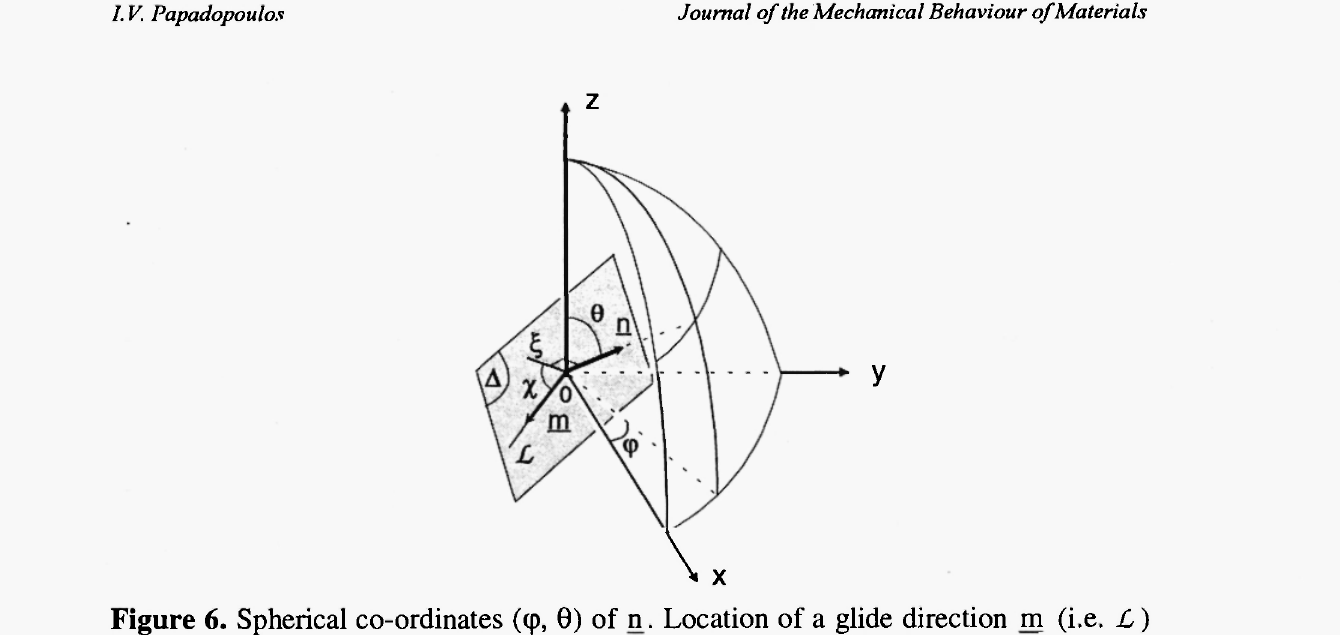
Figure 6. Spherical co-ordinates (φ, θ) of η. Location of a glide direction m (i.e. L) with the help of angle